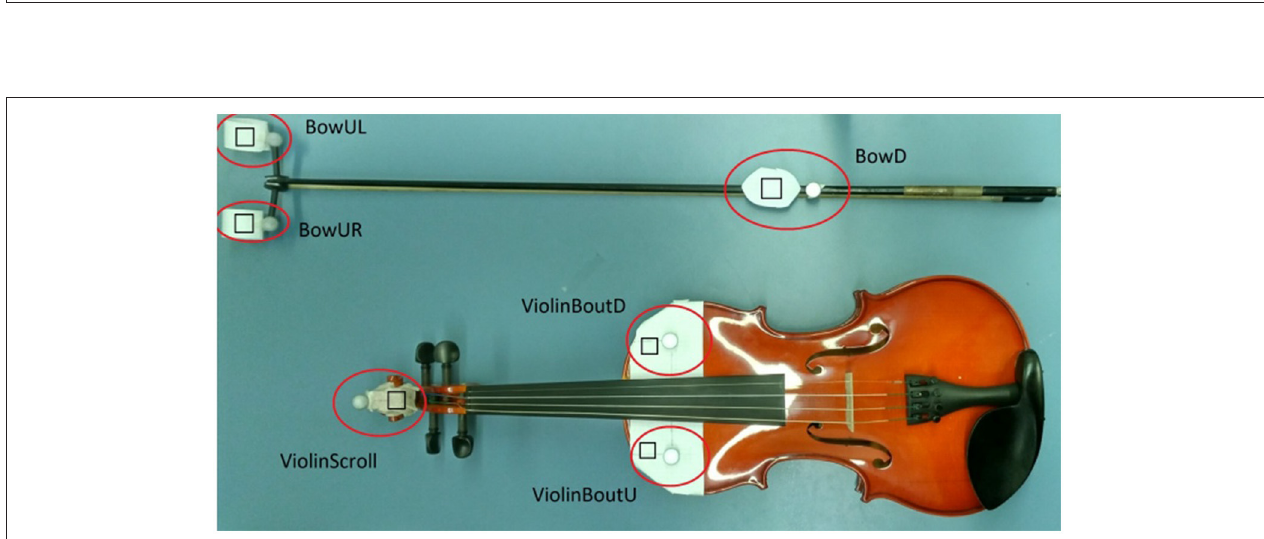
FIGURE 3 | These markers, when placed in the bow and the violin, allow SkyNote to track the bow movement of the participant.